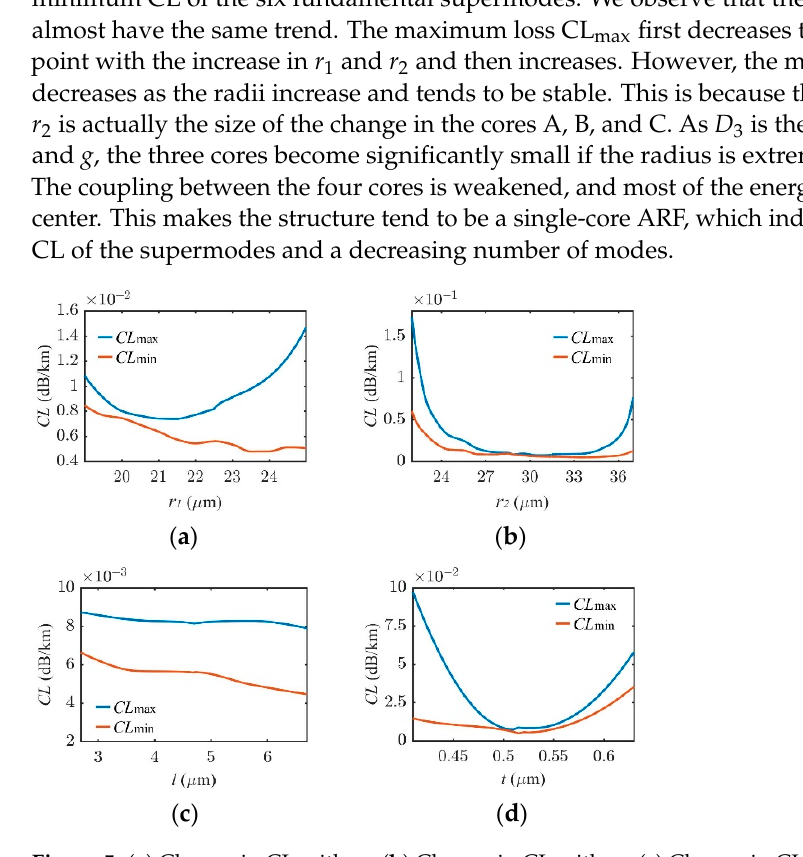
( c ) Figure 6. ( a ) Change in CL with k 1 ; ( b ) Change in CL with k 2 ; ( c ) Change in CL with k 3 . 3.3. Characteristics of Dispersion The chromatic dispersion includes waveguide dispersion and material dispersion. In ARFs, when an optical pulse passes through the structure, the energy is distributed to different modes. Different shapes of the structure have different group velocity responses to different frequency components in a certain mode, resulting in different latency at the output port and waveguide dispersion. Similarly, different frequency components pass- ing through different materials produce different group velocities, which results in group delays at the end of the fiber, resulting in the material dispersion and the broadening of the optical pulse. If the refractive index of the quartz is expressed by the Sellmeier equa- tion, the pulse broadening at different wavelengths can be described by the chromatic dispersion coefficient D as follows [12]: ( )